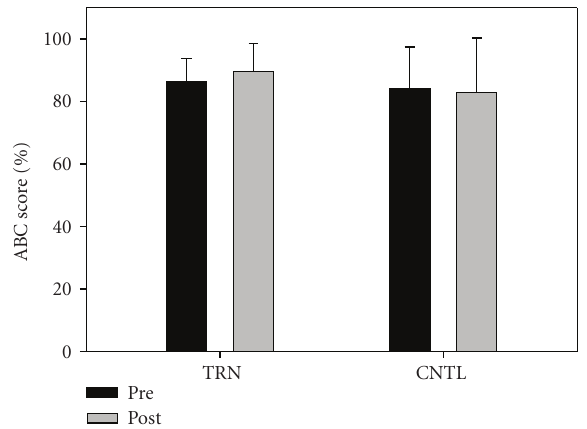
Figure 4: ABC scores (%) for TRN (Pre = 86.2 ± 7.5, Post 89.5 ± 9.0) and CNTL (Pre = 83.9 ± 13.4, Post 82.8 ± 17.5). No significant interaction was noted ( P = .